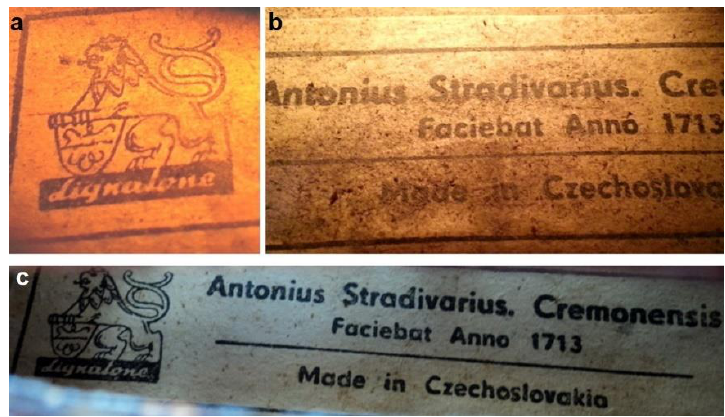
Figure 1. Details ( a , b ) of the label ( c ) of a 1713 Stradivari violin, manufactured after 1891 by the Lignalone company in Czechoslovakia, which was examined in our laboratory.